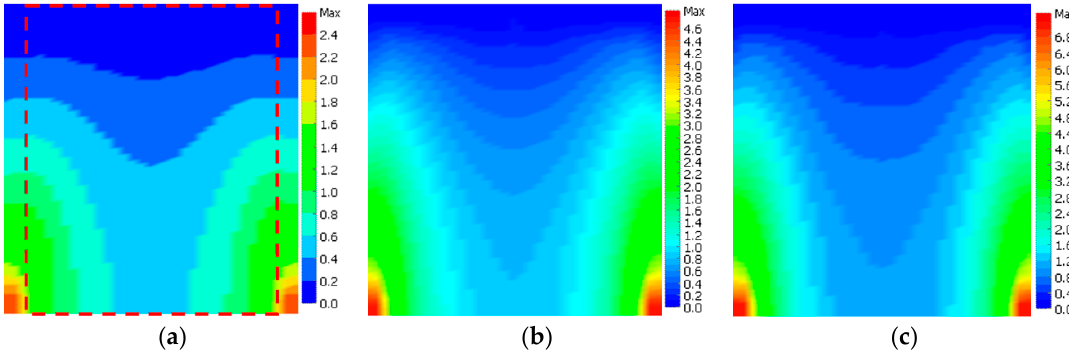
Figure 2. Simulated electric potential distribution within the LC bulk of the proposed model at ( a ) V on = 2.4 V rms , ( b ) V on = 4.8 V rms , ( c ) V on = 7.2 V rms , respectively (the area of individual LC microlens is framed by a red dotted frame in Figure 2a).